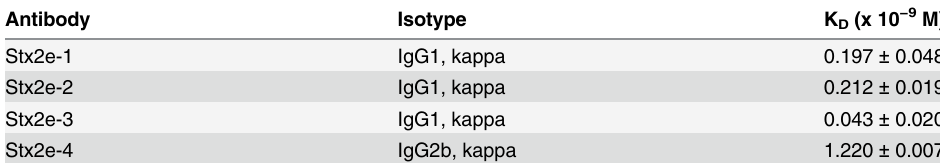
Table 2. Properties of Stx2e mAbs.